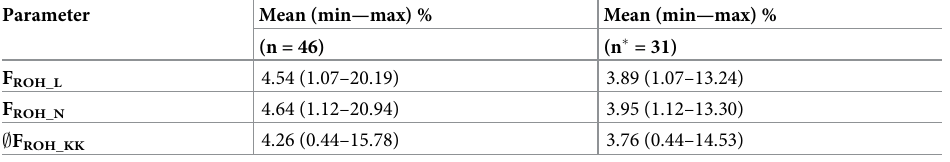
Table 4. Inbreeding coefficients estimated from the runs of homozygosity (ROH) applying different computa- tional measures on the German White-headed Mutton individuals.